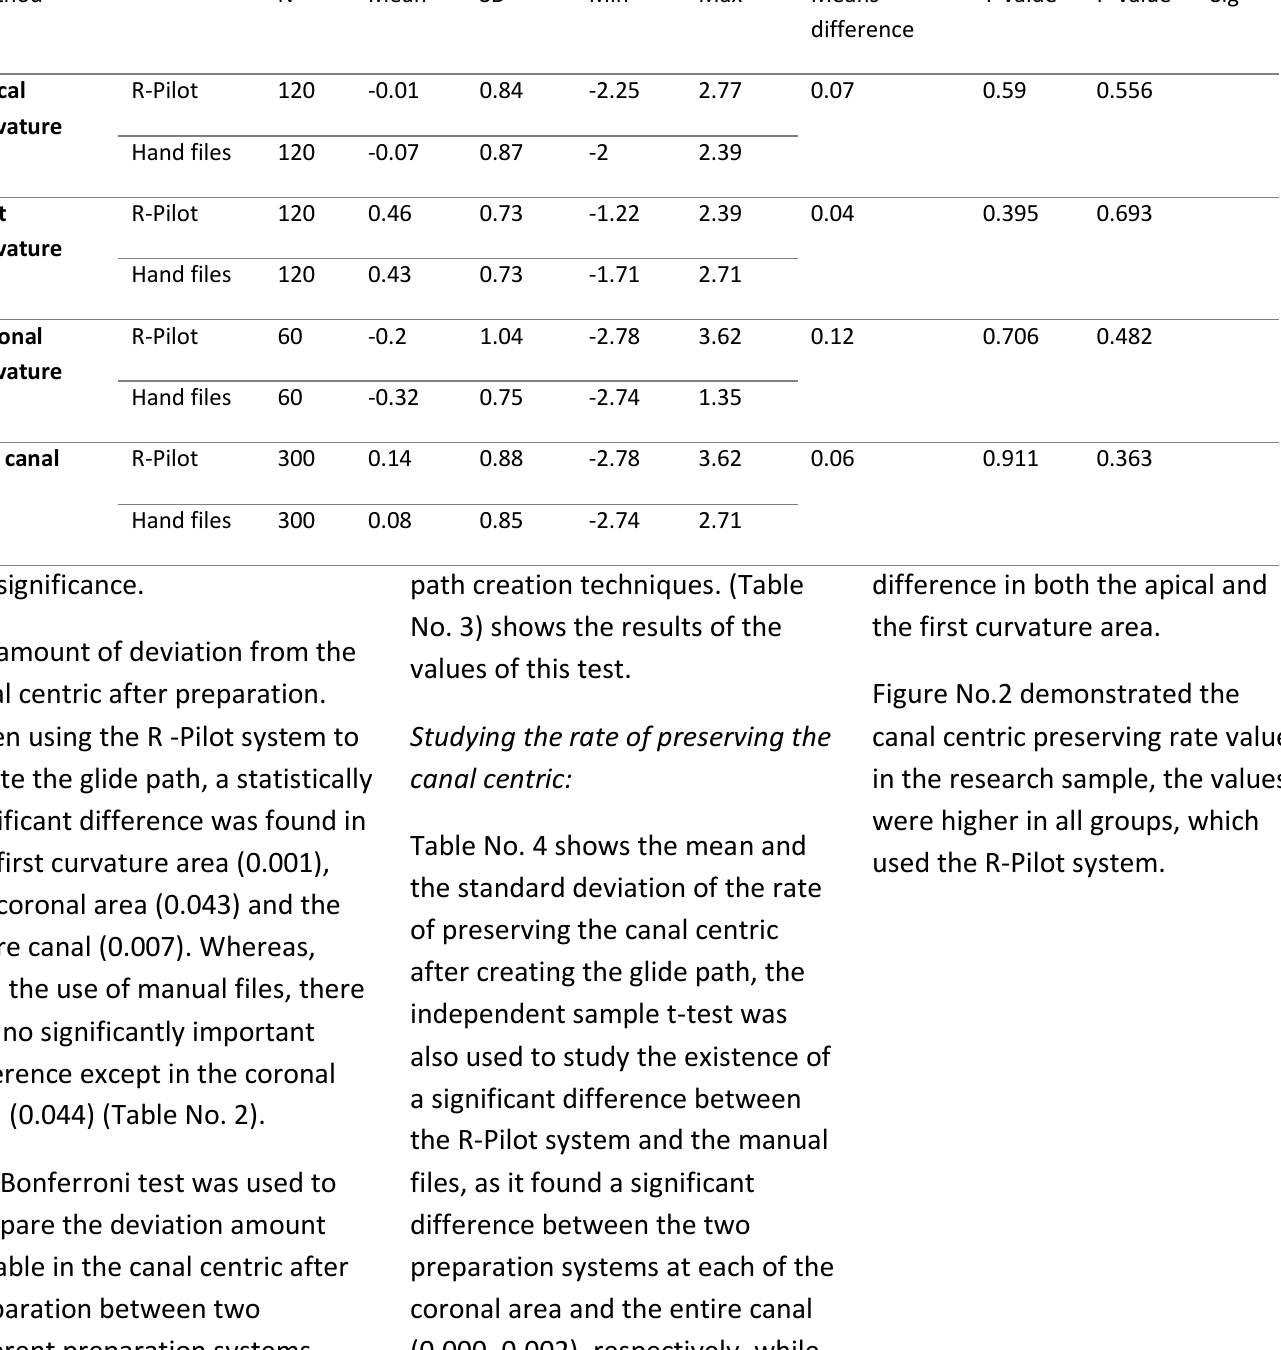
Table 1: Studying the deviation from the canal centric Method